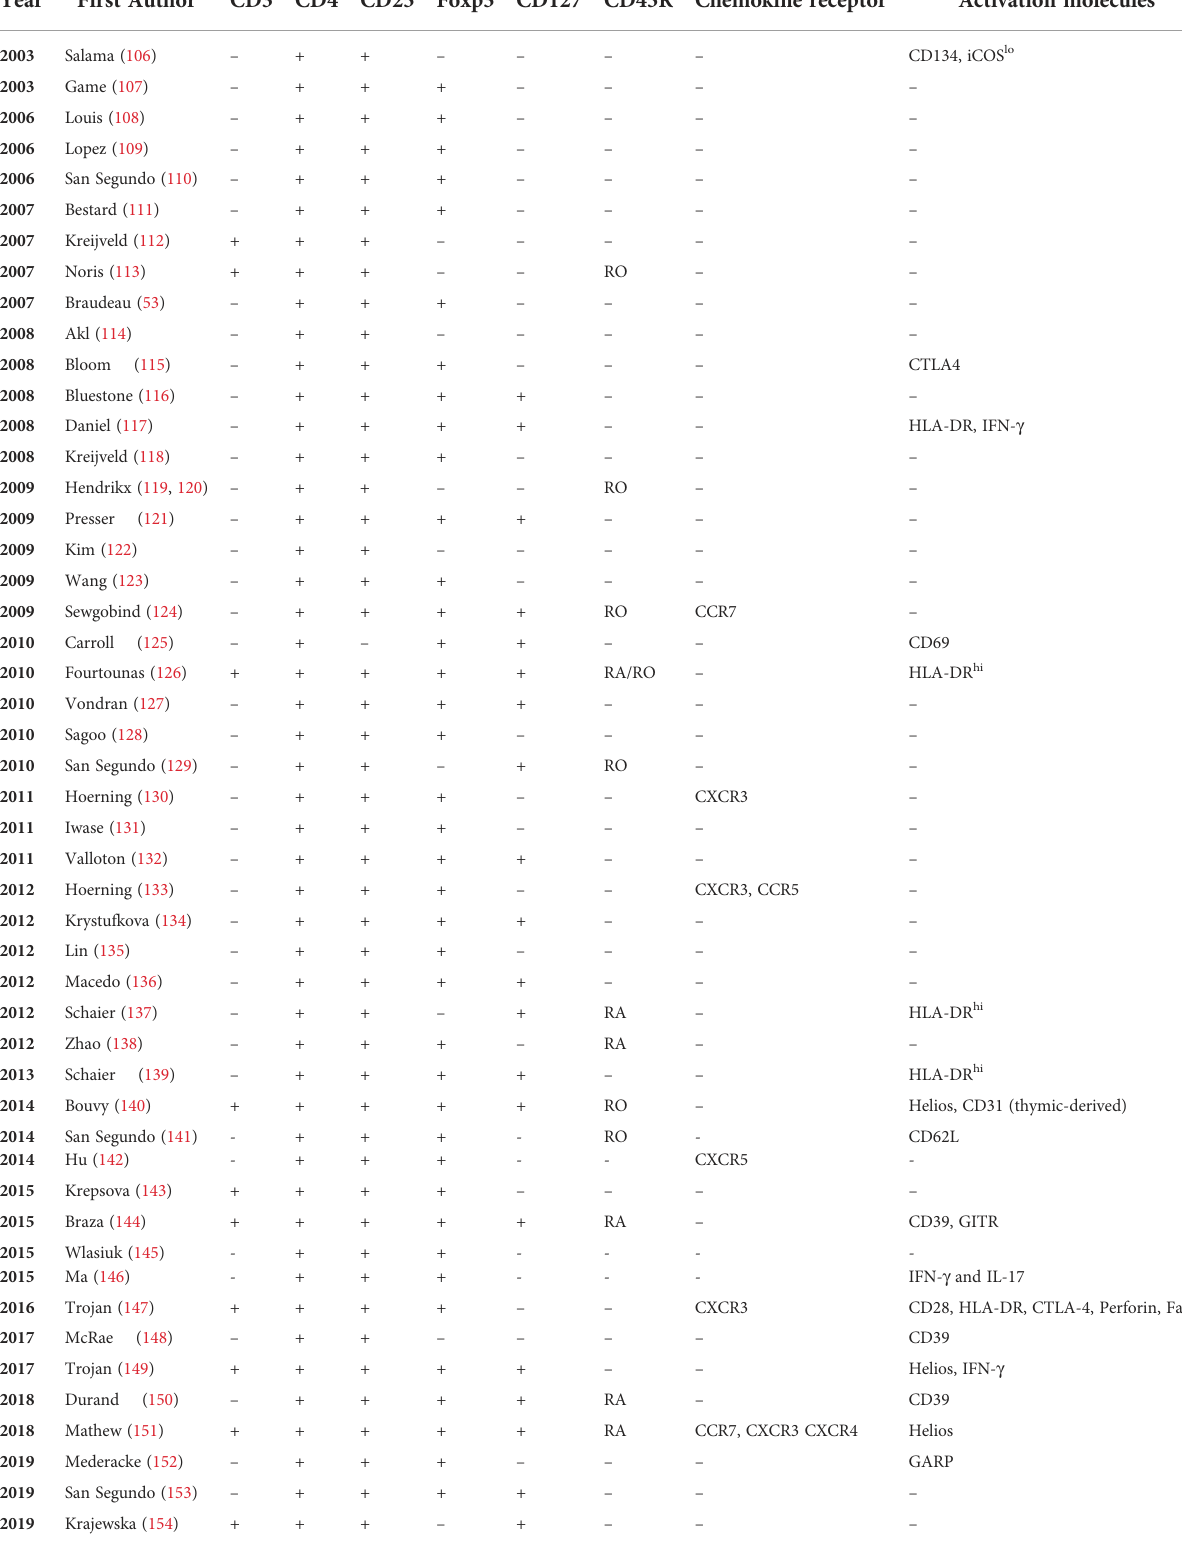
TABLE 2 Markers used to identify T regulatory cells in renal